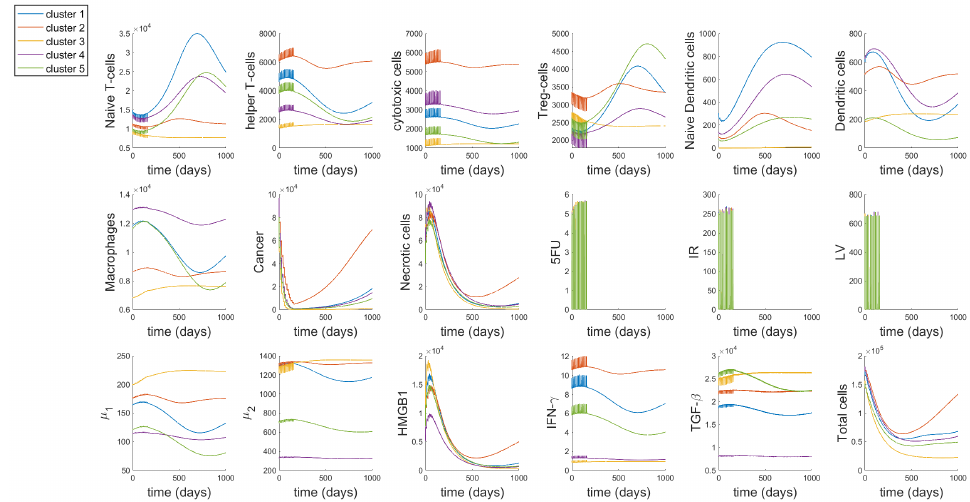
Figure 3. Whole system dynamics with initial conditions as median drug doses from patient data and steady-state values for the cells. The different colour lines depict the different dynamics of each cluster. ‘Total cells’ is the sum of all immune, cancer and necrotic cells excluding